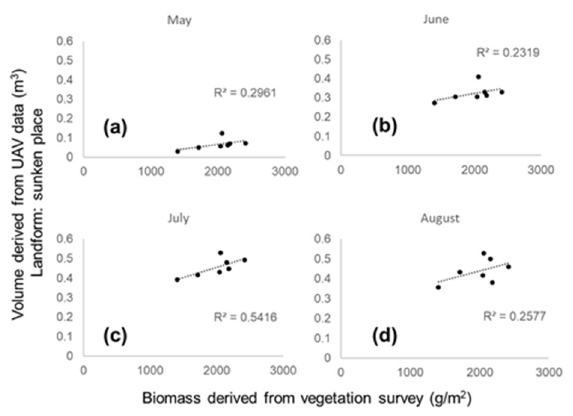
Figure 9. Comparison between volume of M. sinensis derived from UAV data: May (a), June (b), July (c) and August (d), and